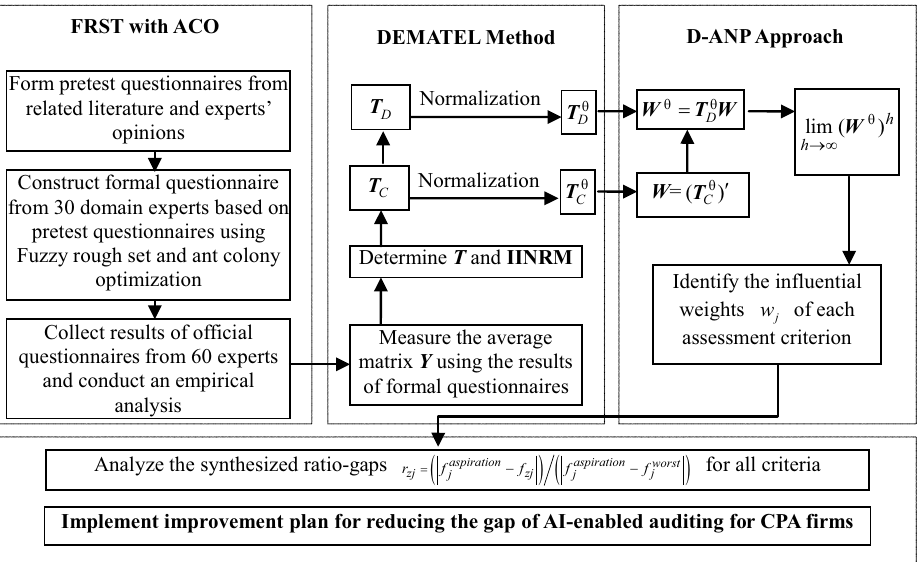
Figure 3. Integrated techniques and methods of a fusion MRDM